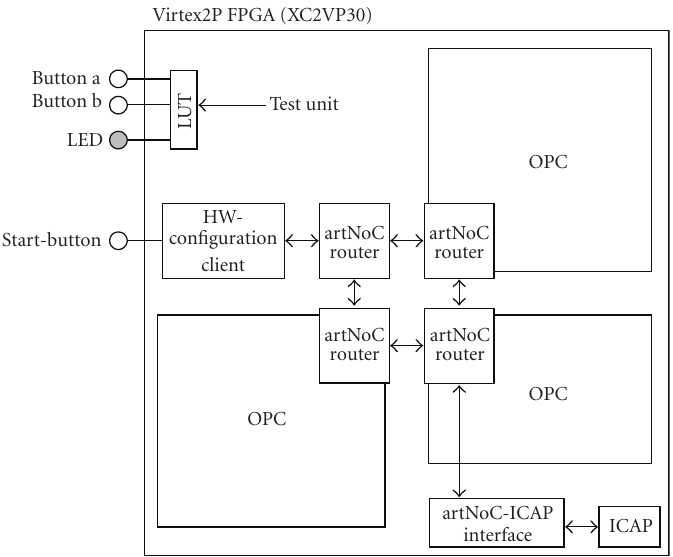
Figure 10: Measurement test setup.